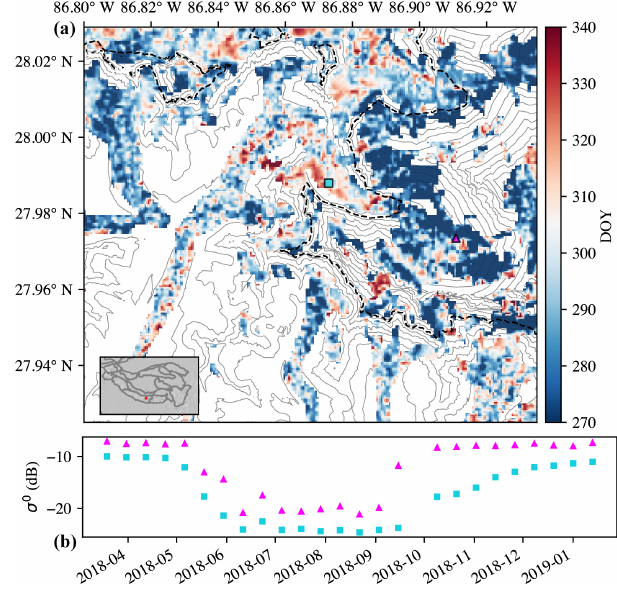
Figure 7. (a) Refreeze timing over the Khumbu Glacier region of Mount Everest in the central Himalaya. Red regions of freeze onset occur at mid-elevations, indicative of delayed refreeze due to melt- water retention in percolation zones. The dashed elevation contour line is drawn at 6300m, which was the maximum elevation of a 0 ◦ C isotherm for the calendar year 2018. (b) Sentinel-1 backscatter time series from two points on the Khumbu Glacier, one within known elevations of glacier percolation facies (teal square; 6000ma.s.l.) and another point at elevations where temperatures likely do not exceed 0 ◦ C annually (pink triangle;